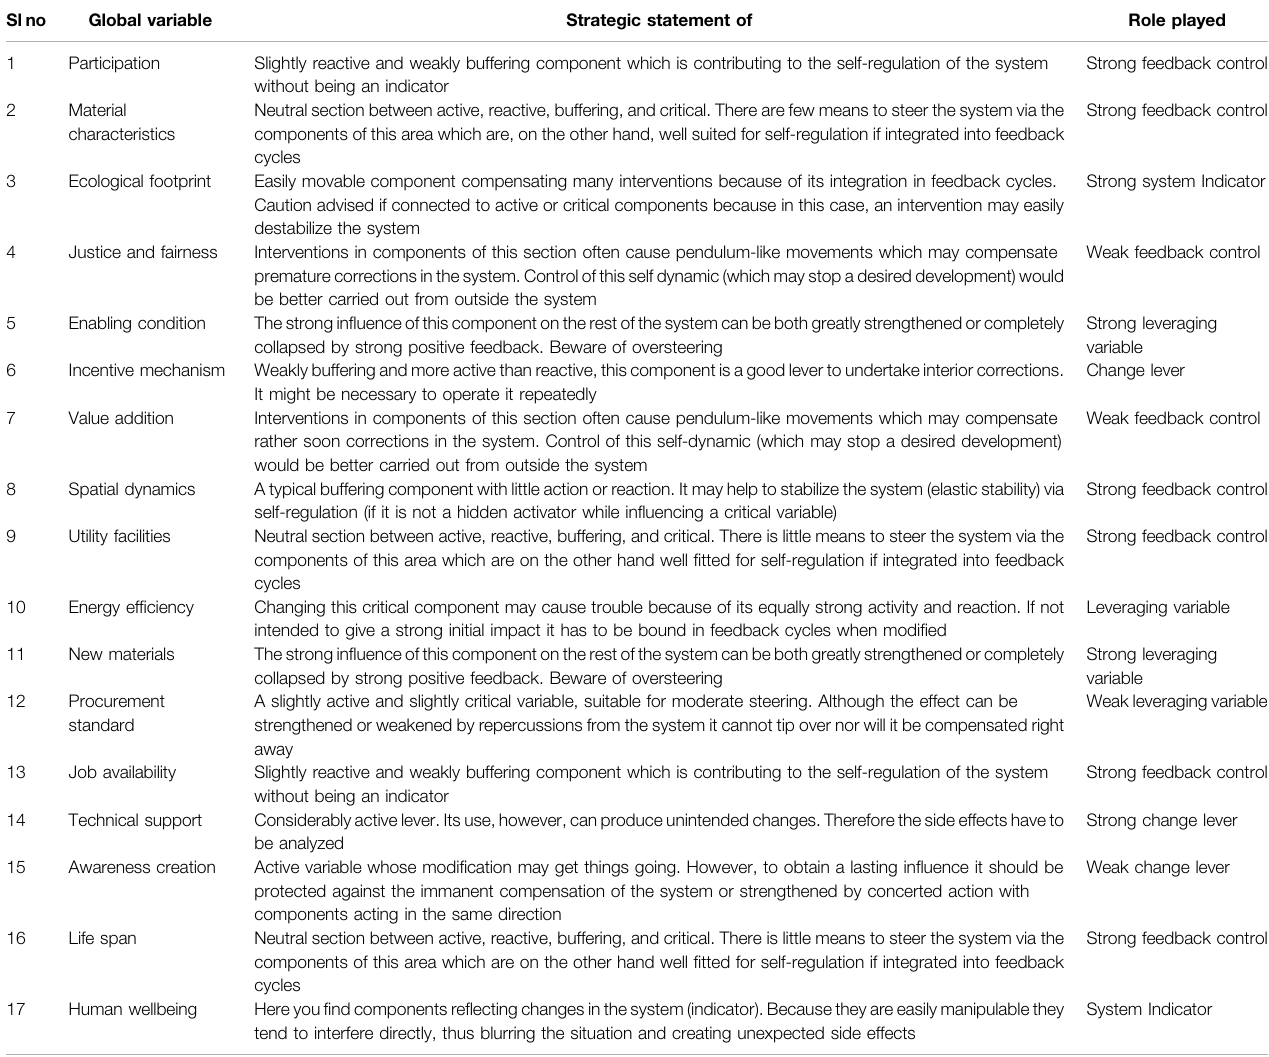
TABLE 3 | Strategic statement of the variables in two-dimensional